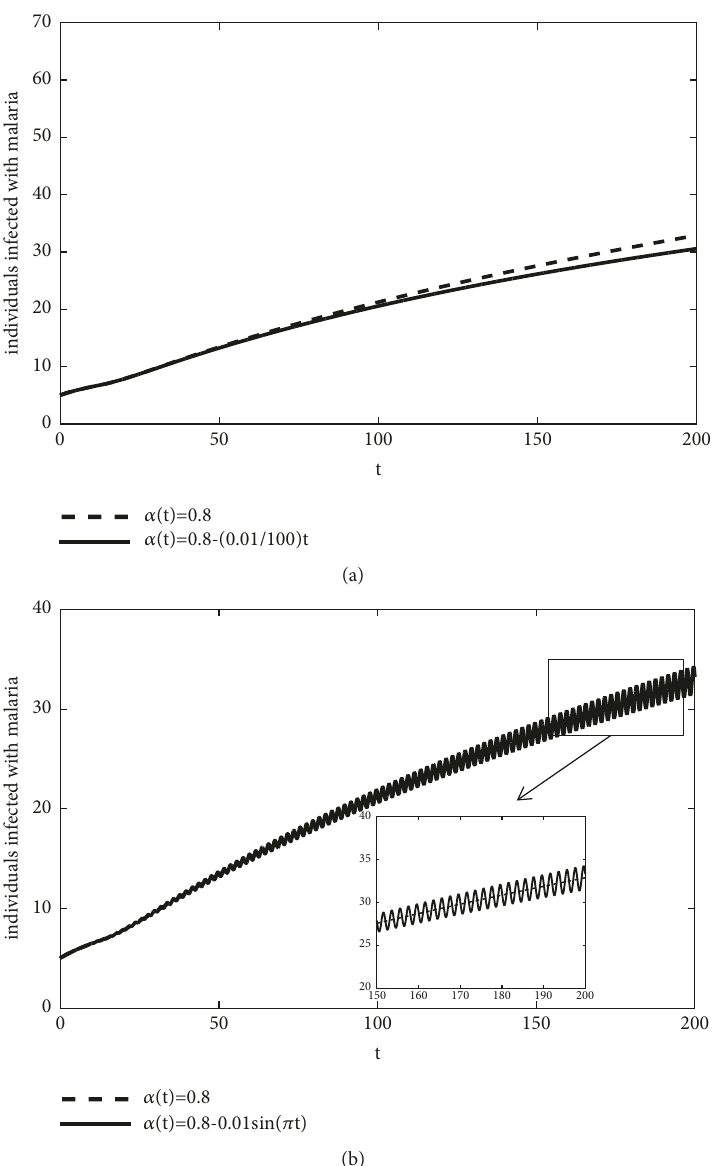
Figure 5: Individuals infected with malaria with 𝜓 = 2 . Parameters values are in Table 1 with 𝛽 ℎ = 0.05 . (a) 𝛼(𝑡) = 0.8 comparing with 𝛼(𝑡) = 0.8 − (0.01/100)𝑡 ; (b) 𝛼(𝑡) = 0.8 comparing with 𝛼(𝑡) = 0.8 − 0.01 sin (𝜋𝑡) .